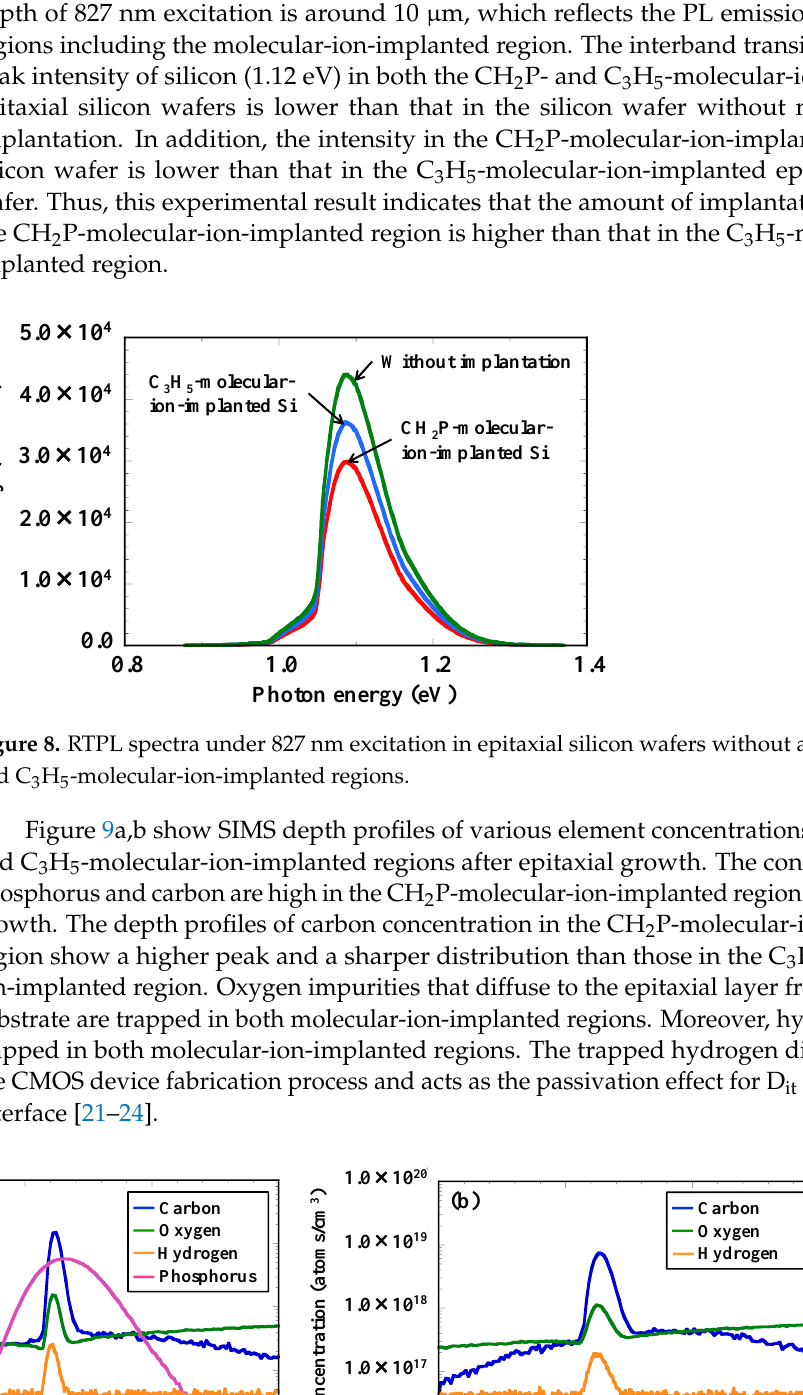
Figure 7. ( a ) Cross-sectional TEM images of CH 2 P- and C 3 H 5 -molecular-ion-implanted regions with epitaxial silicon wafers. ( b ) Density of black pointed defects distributed in CH 2 P- and C 3 H 5 -molec- ular-ion-implanted regions.